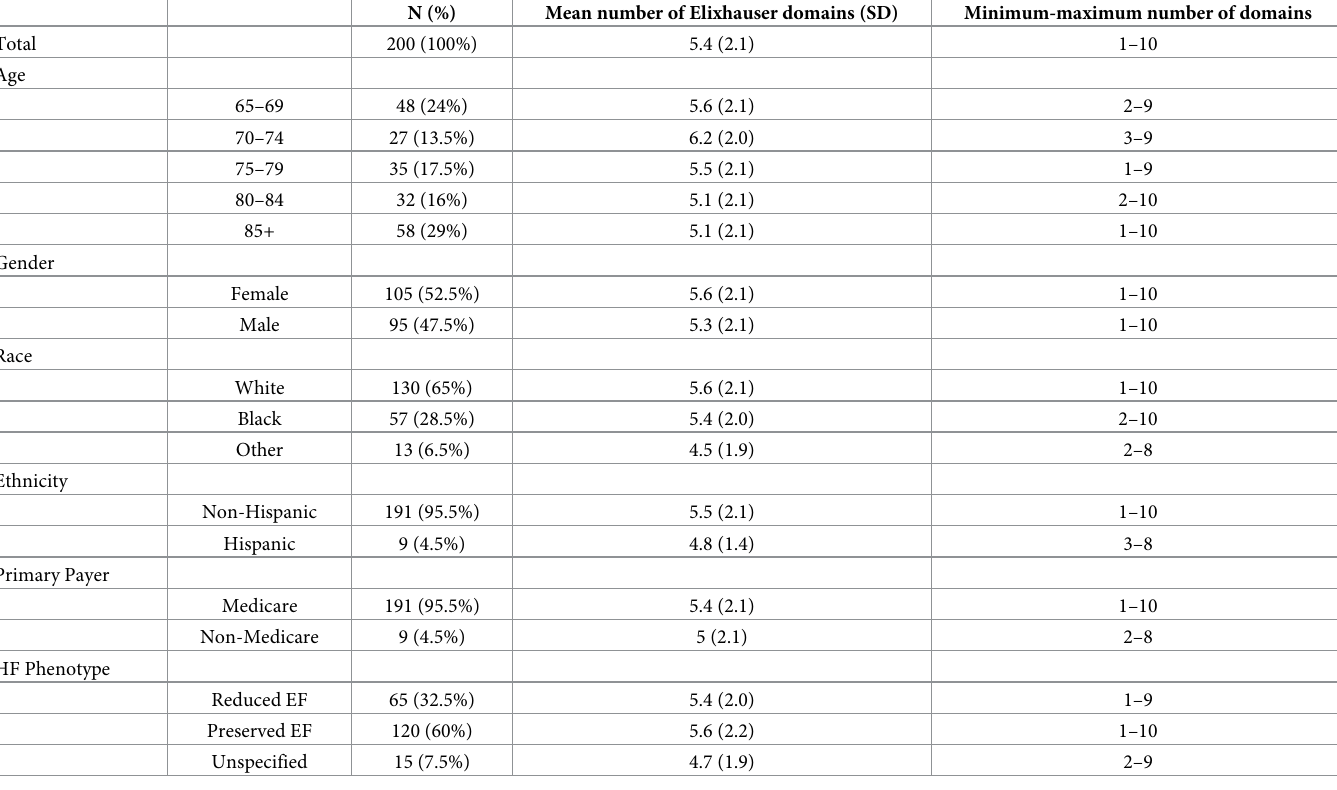
Table 1. Demographics of study sample and level of multimorbidity by subgroup. N (%) Mean number of Elixhauser domains (SD) Minimum-maximum number of